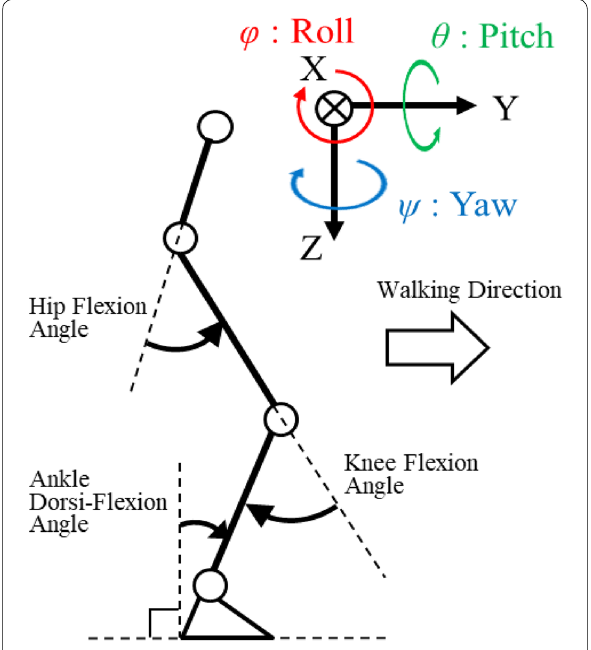
Fig. 1 Definition of the lower limb joint angles and the reference coordinate